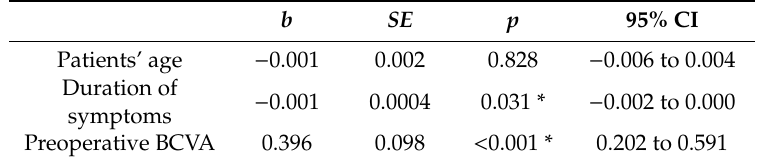
Table 4. The e ff ect of preoperative patient-related factors on postoperative best-corrected visual acuity (BCVA). b SE p 95% CI Patients’ age − 0.001 0.002 0.828 − 0.006 to 0.004 − 0.001 0.0004 symptoms